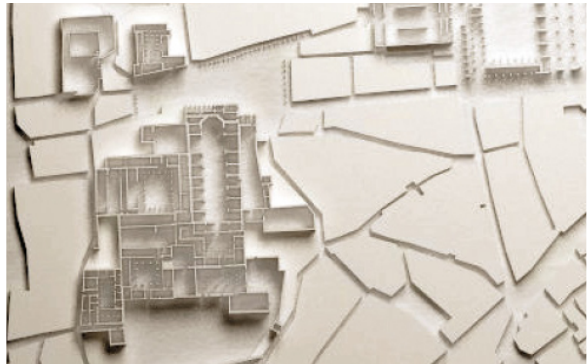
Figure 10. City scale. The reconstruction of urban hypotheses serves as a support to explain the historiography of cities (The authors, 2018)